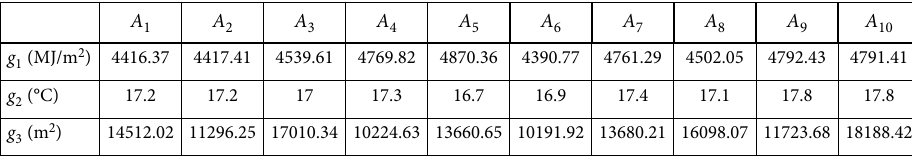
Table 3. Performance of projects on quantitative attributes (source: Wu et al., 2018)